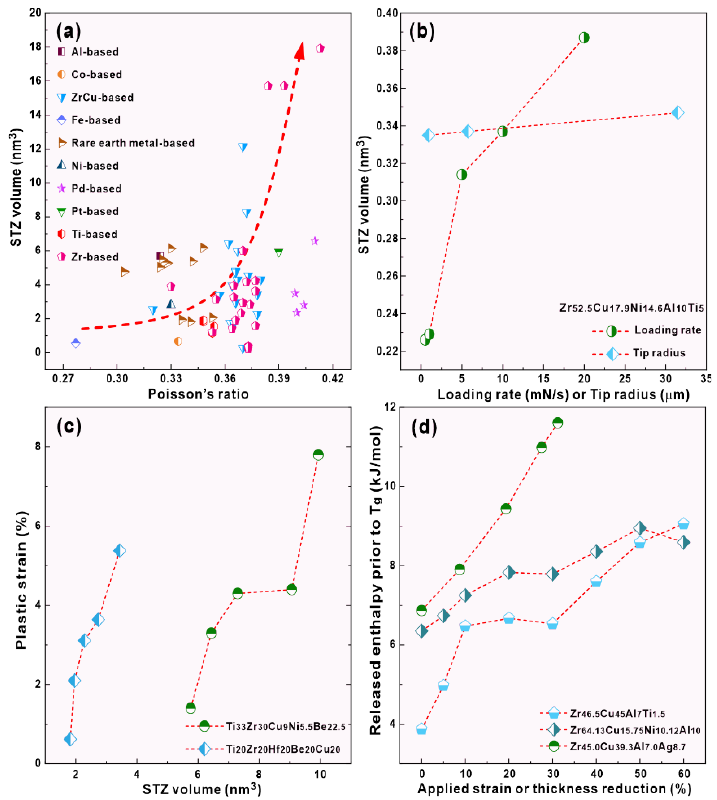
Figure 6. ( a ) Correlation between the STZ volumes and Poisson’s ratios in different systems BMGs (Red arrow indicates the increasing tendency), ( b ) the change in the STZ volumes with increasing loading rate or tip radius during nanoindentation [42,53], ( c ) correlation between the STZ volumes